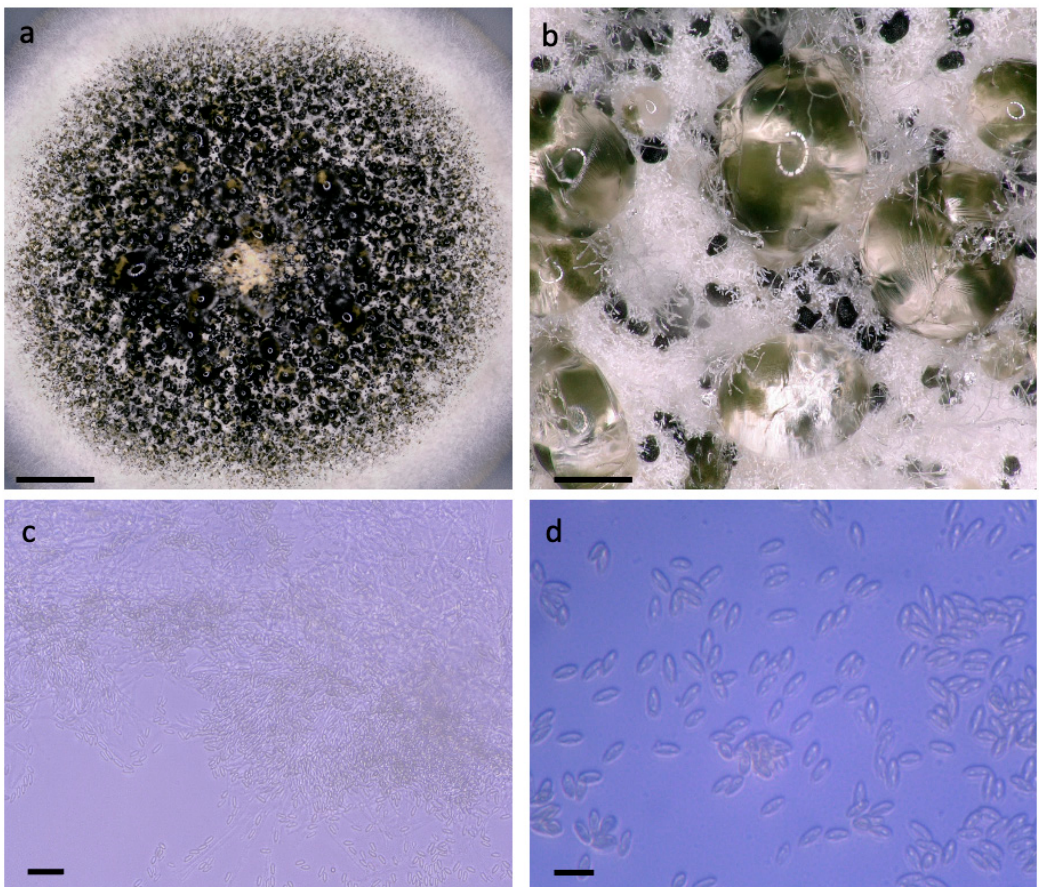
Figure 1. Photomicrographs of CABI-IMI 368023. Images ( a – d ) are captured on Keyence VHX5000 light microscope at 20, 200, 1000 and 2500× magnification, respectively. ( a ) Culture morphology with dark region of sporulation surrounded by white mycelial margin, bar = 5 mm. ( b ) Dark spore masses embedded in white arial mycelia and droplets of condensation, bar = 400 μ m. ( c ) Closer examination of free conidia and dense hyphal mass, bar = 25 μ m. ( d ) Elongated conidia, lacking fantail appendage, bar = 10 μ m.